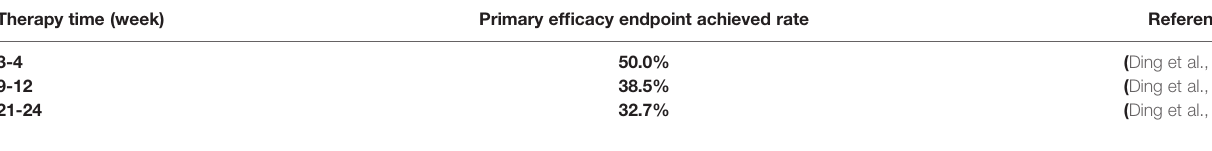
TABLE 1-3 | The clinical ef fi cacy of FMT reported in different treatment routes. Treatment